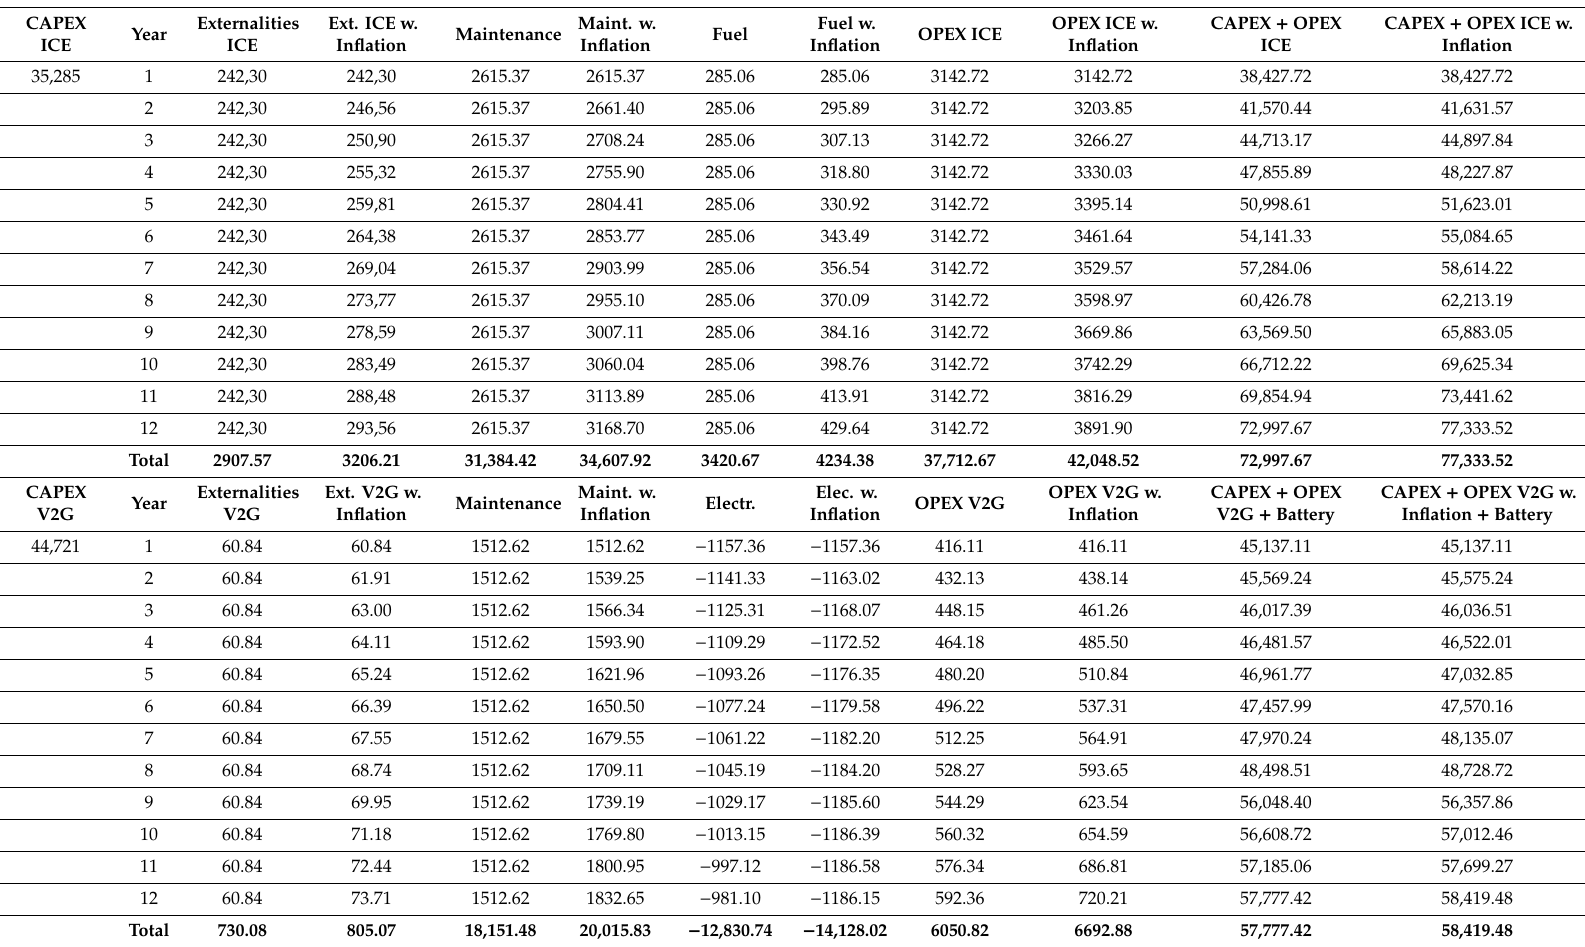
Table A3. Cumulative costs for ICE and V2G solutions, occasional drivers (figures are in